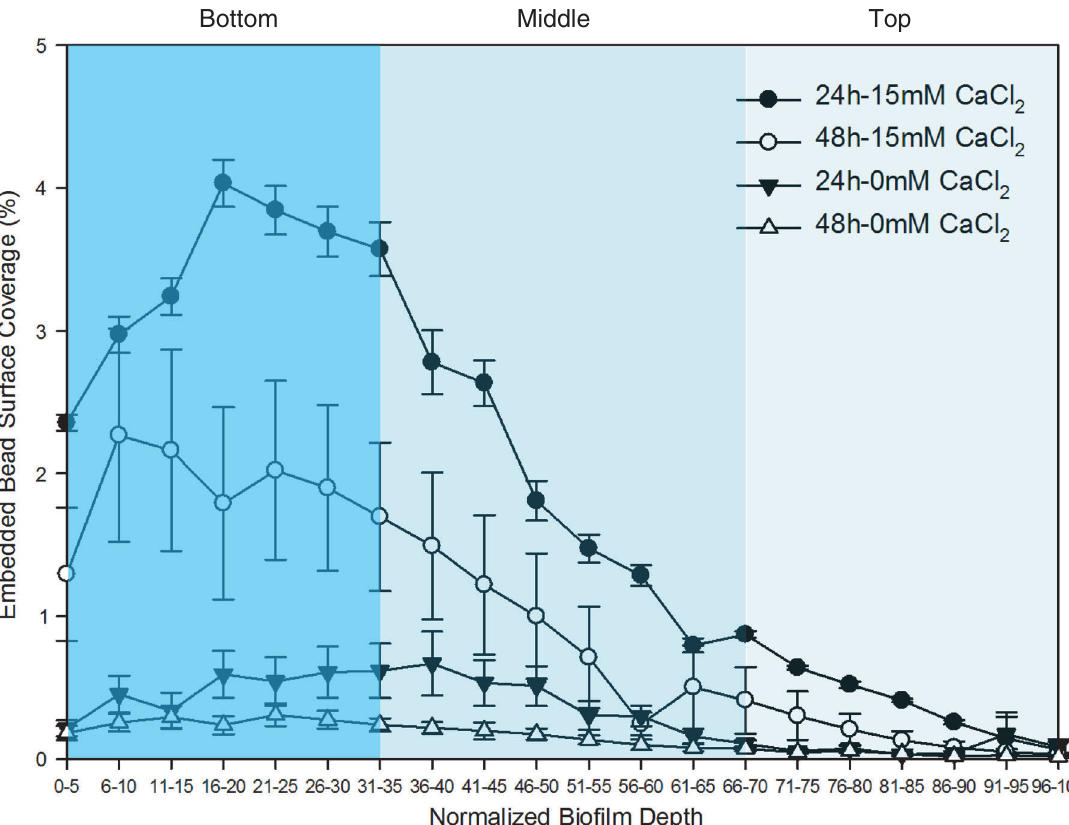
Fig. 2. Spatial strati fi cation of embedded fl uorescent 1 μ m beads presented as surface coverage (%) vs. bio fi lm depth following 24 h, 48 h bio fi lm development in the absence and presence of CaCl 2 . Error bars represent standard error of the